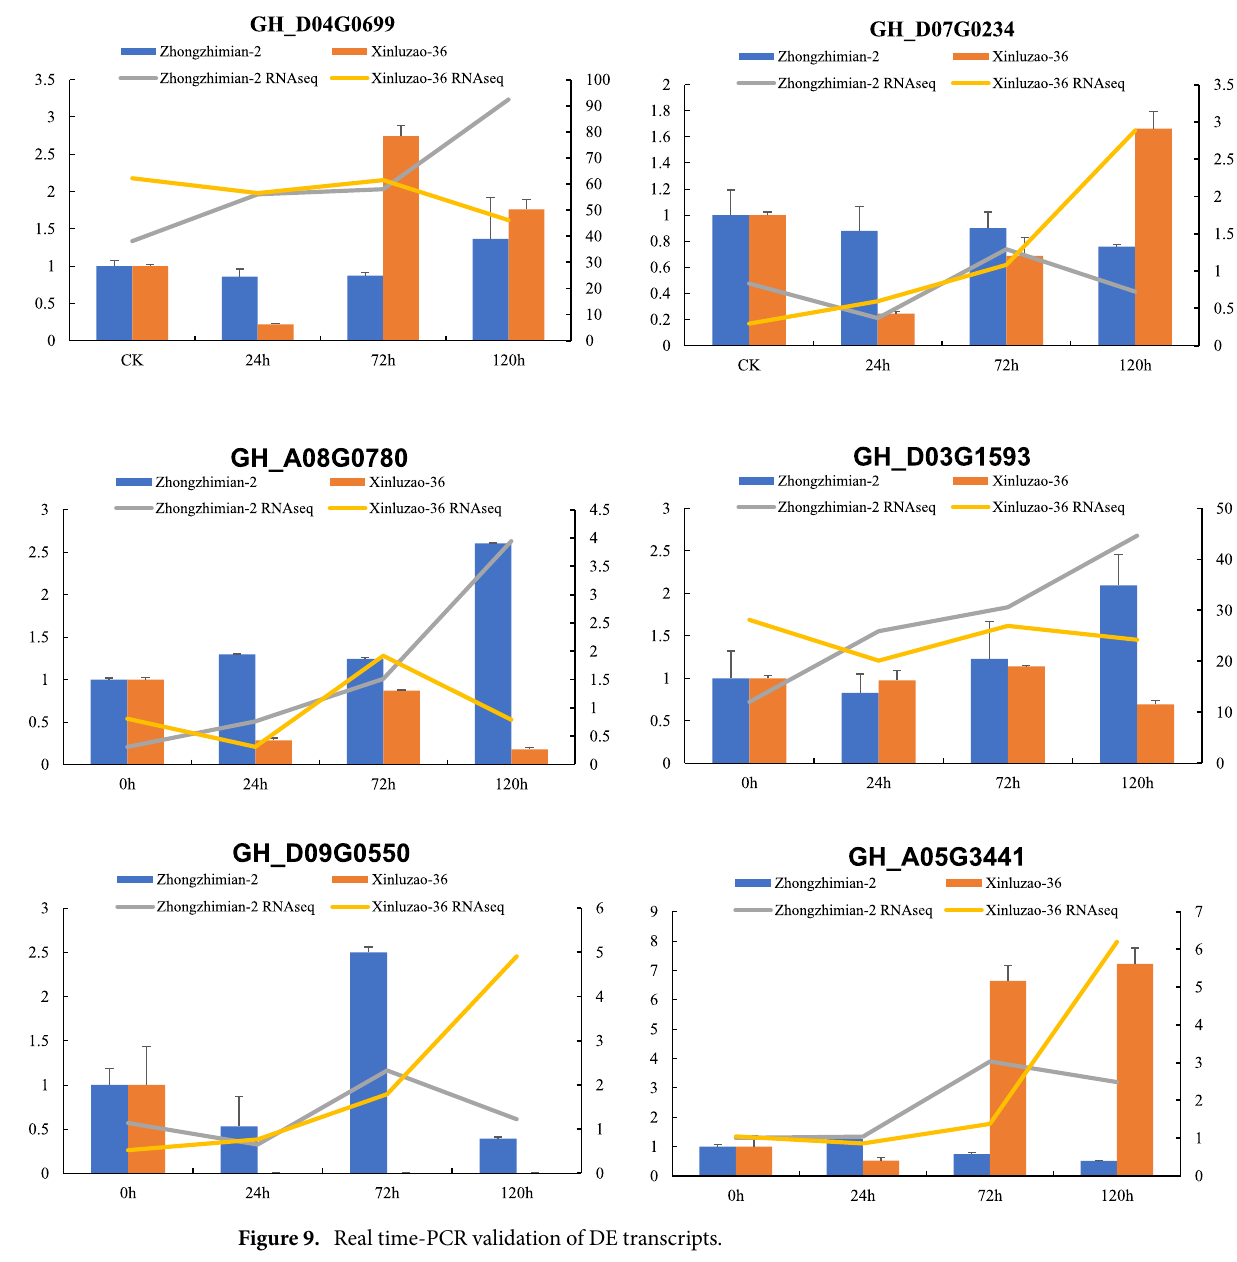
Figure 9. Real time-PCR validation of DE